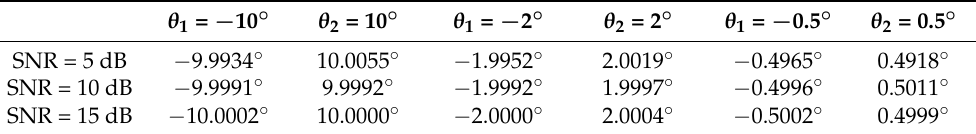
Table 1. The angular resolution analysis of the proposed